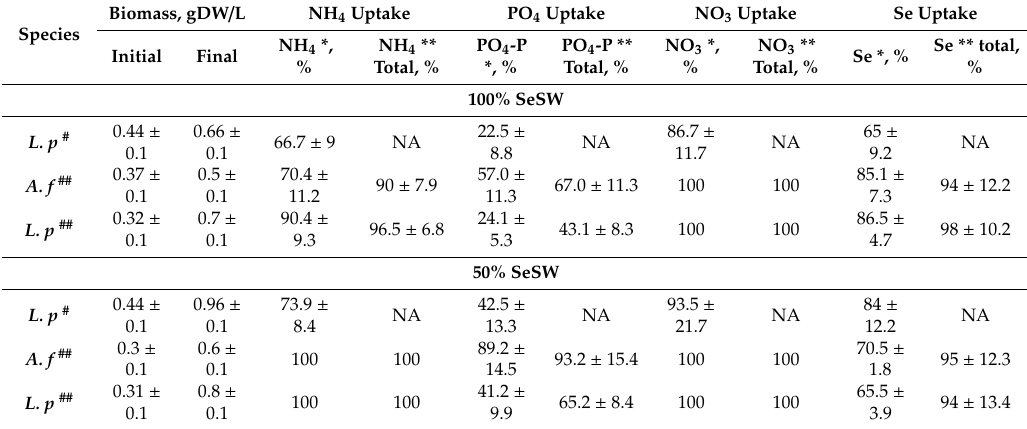
Table 1. Nutrients removal from SeSW by L. punctata followed by A. filiculoides or L. punctata .